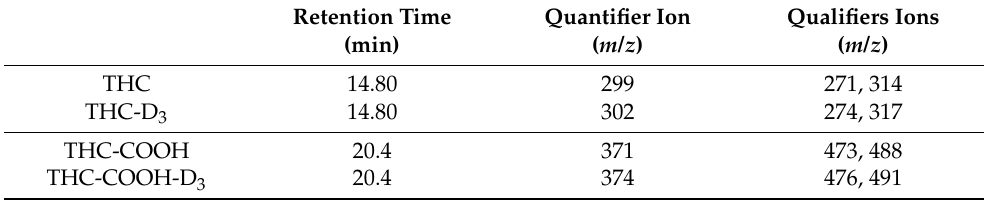
Table 5. Retention times and ions selected for